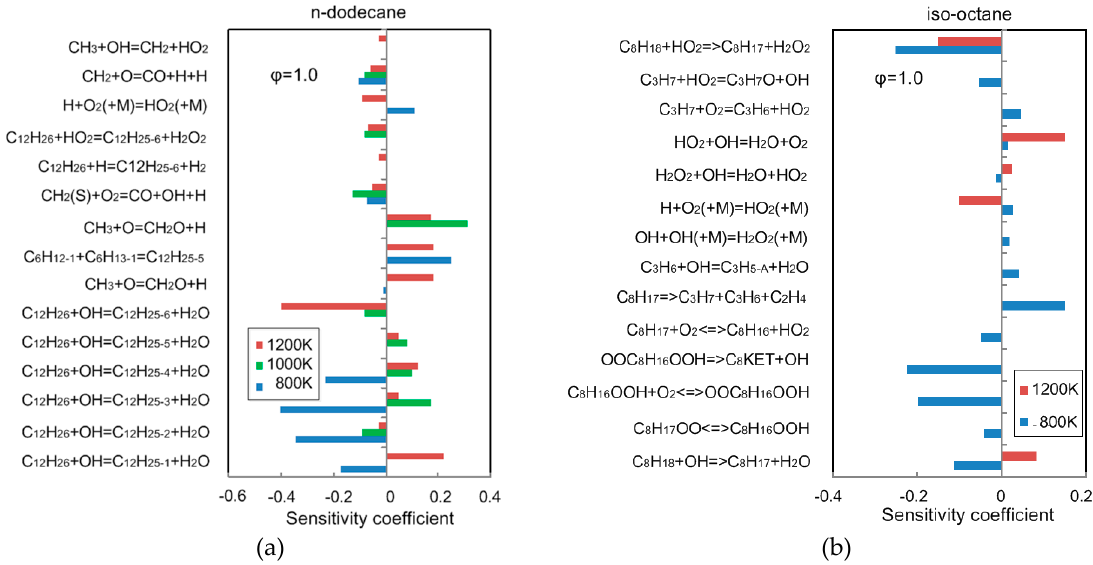
Figure 7. Sensitivity coefficient of ignition delay time at P =2.0MPa and φ =1.0 with (a) n-dodecane;(b) iso-octane.